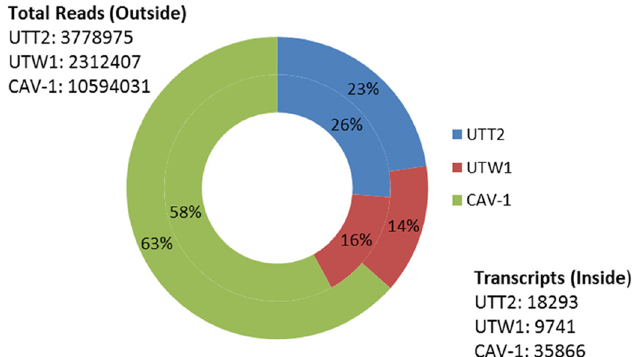
Fig 2. Distributions of detected reads and transcripts. The outside ring represents the number of initial reads and the inside ring represents the number of detected transcripts for A . tridentata tridentata (UTT2), A . tridentata wyomingensis (UTW1) and A . arbuscula (CAV-1). Reflecting the number of reads, the majority of detected transcripts were from CAV-1, while both UTT2 and UTW1 had a similar number of reads between